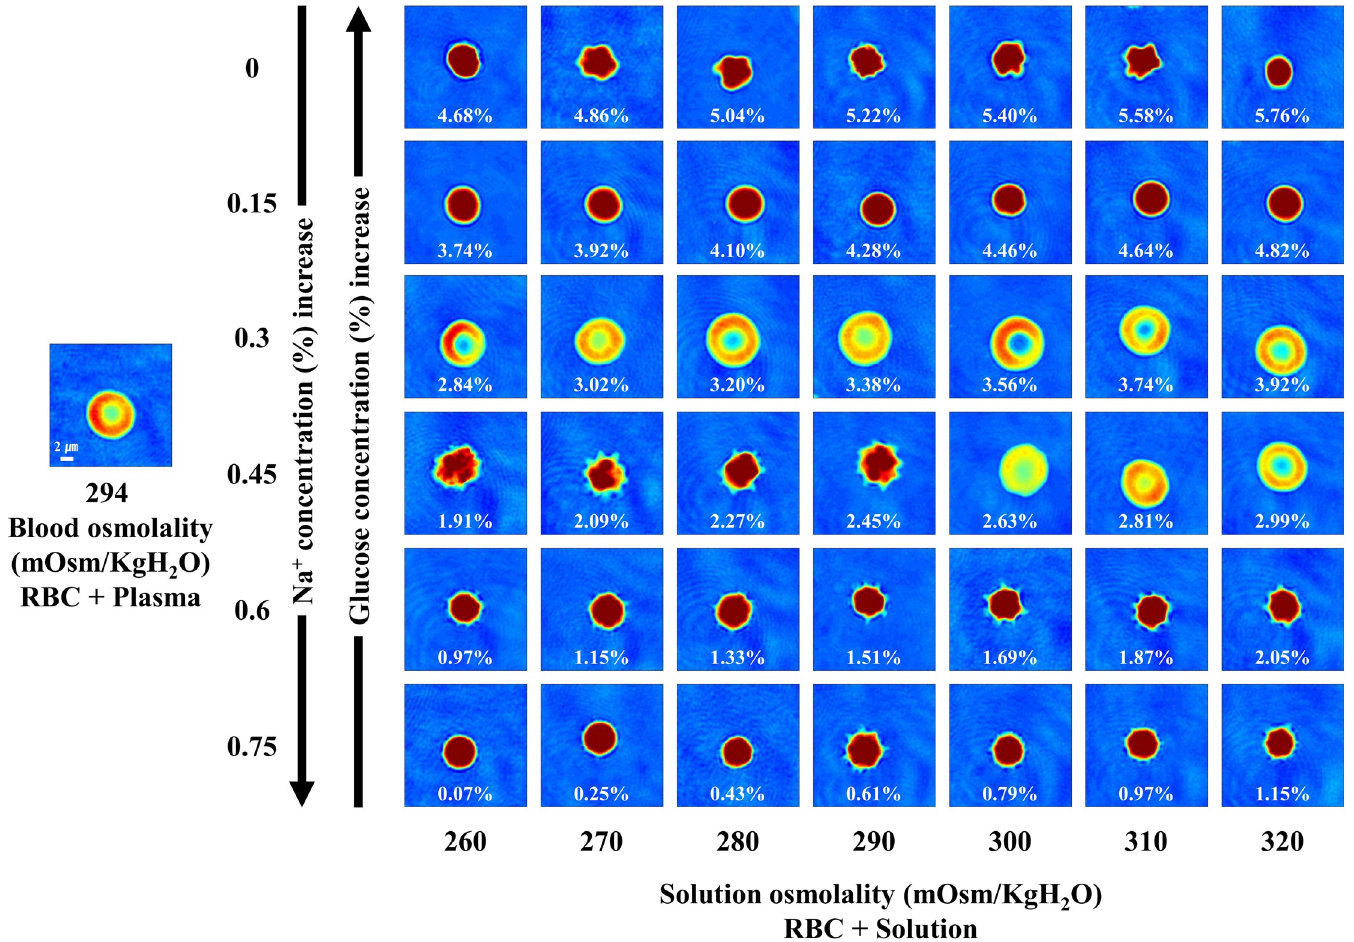
Fig 3. 2D images presenting the morphology of RBCs for one healthy subject in sodium chloride and glucose solutions. The level of sodium chloride was fixed at 0%, 0.15%, 0.3%, 0.45%, 0.6%, and 0.75%, and glucose was mixed according to the respective osmolality. The value in each panel represents the concentration of glucose.